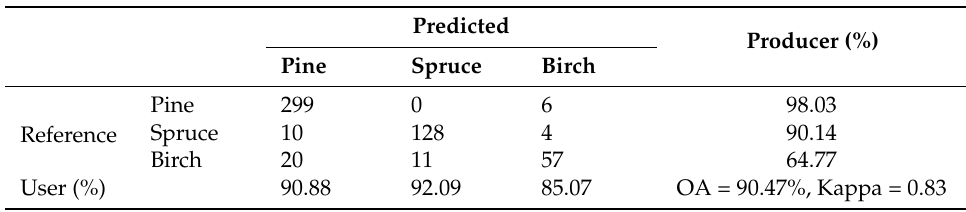
Table 10. Confusion matrix of classification with point cloud and single-channel intensity features for isolated and dominant trees (C1).